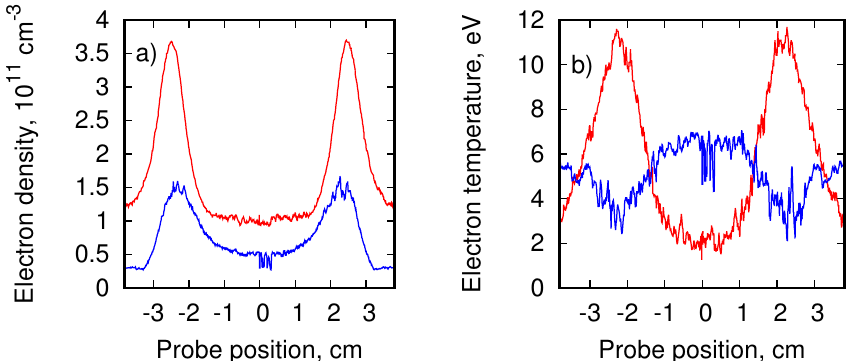
Figure 6. Electron density and temperature profiles in pure H and mixed ArH plasmas. In the evaluation of the current-voltage characteristics of Langmuir probe measurements, the effective ion ) / ( F + F ) was used. Electron density is shown in ( a ) and electron mass µ = ( m Ar F Ar + m H F H H 2 Ar 2 temperature in ( b ). The data for H plasma are shown using the red color, and the data for ArH mixed plasma are shown using the blue color. The probe is moved in the vertical position at PSI-2 at a distance of 50 cm from the targets from the top toward the z axis and back. The probe characteristics obtained during the motion toward the axis are distinguished from another set using negative values for probe